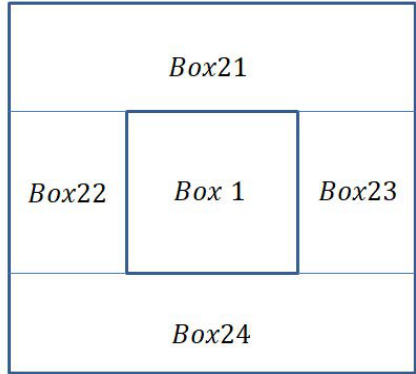
Figure 1. The integration subdomains for level-2 box.